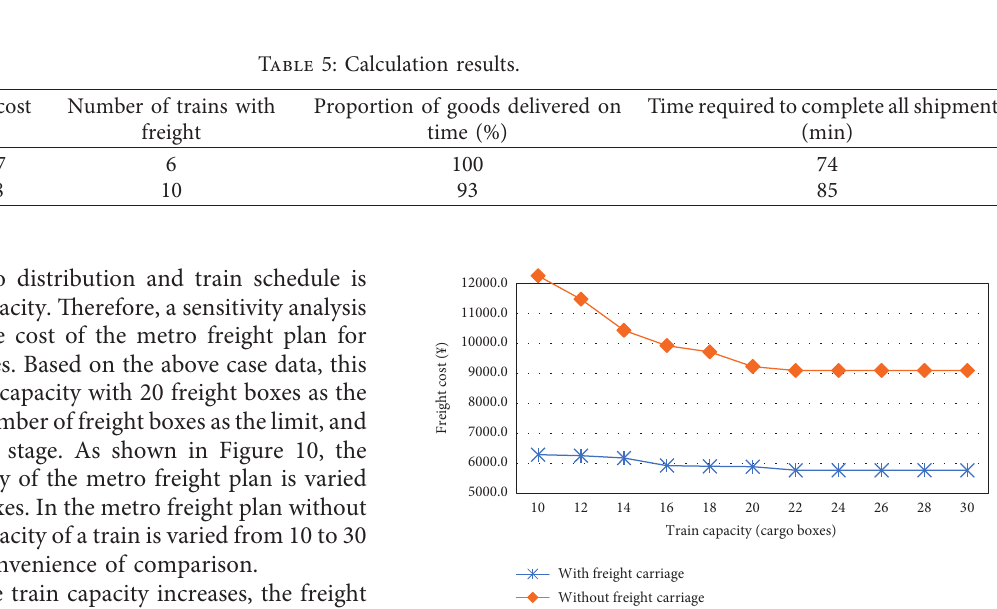
Figure 10: Schematic diagram of train capacity and freight